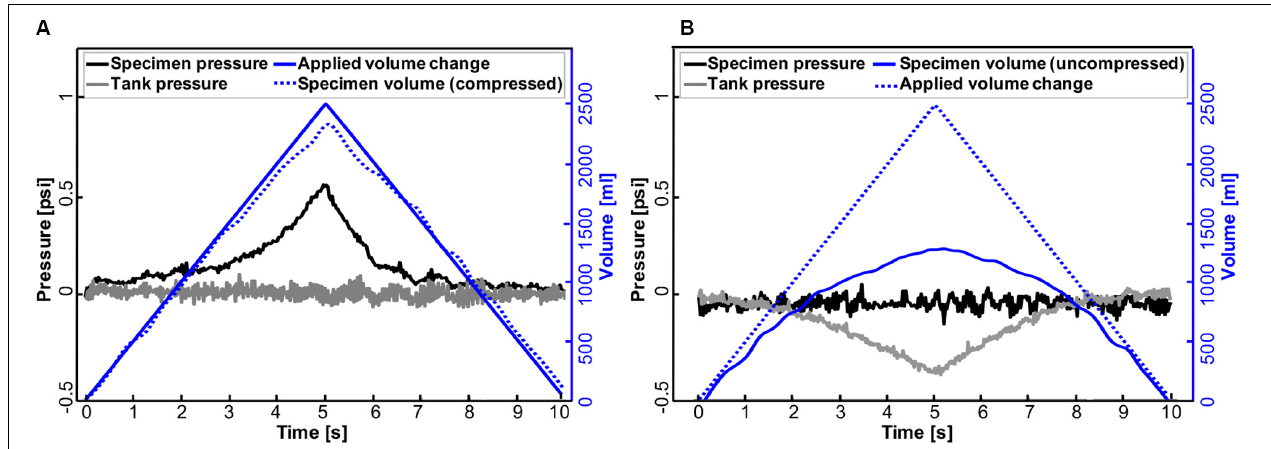
FIGURE 7 | Representative pressure-time response of the accordion bladder and tank to volume changes in positive- (A) and negative-pressure ventilation (B) at a constant inflation-deflation rate of 500 ml/s. Changes in air volume applied to the bladder (PPV) and tank (NPV) are mirrored in bladder pressure and tank pressure,